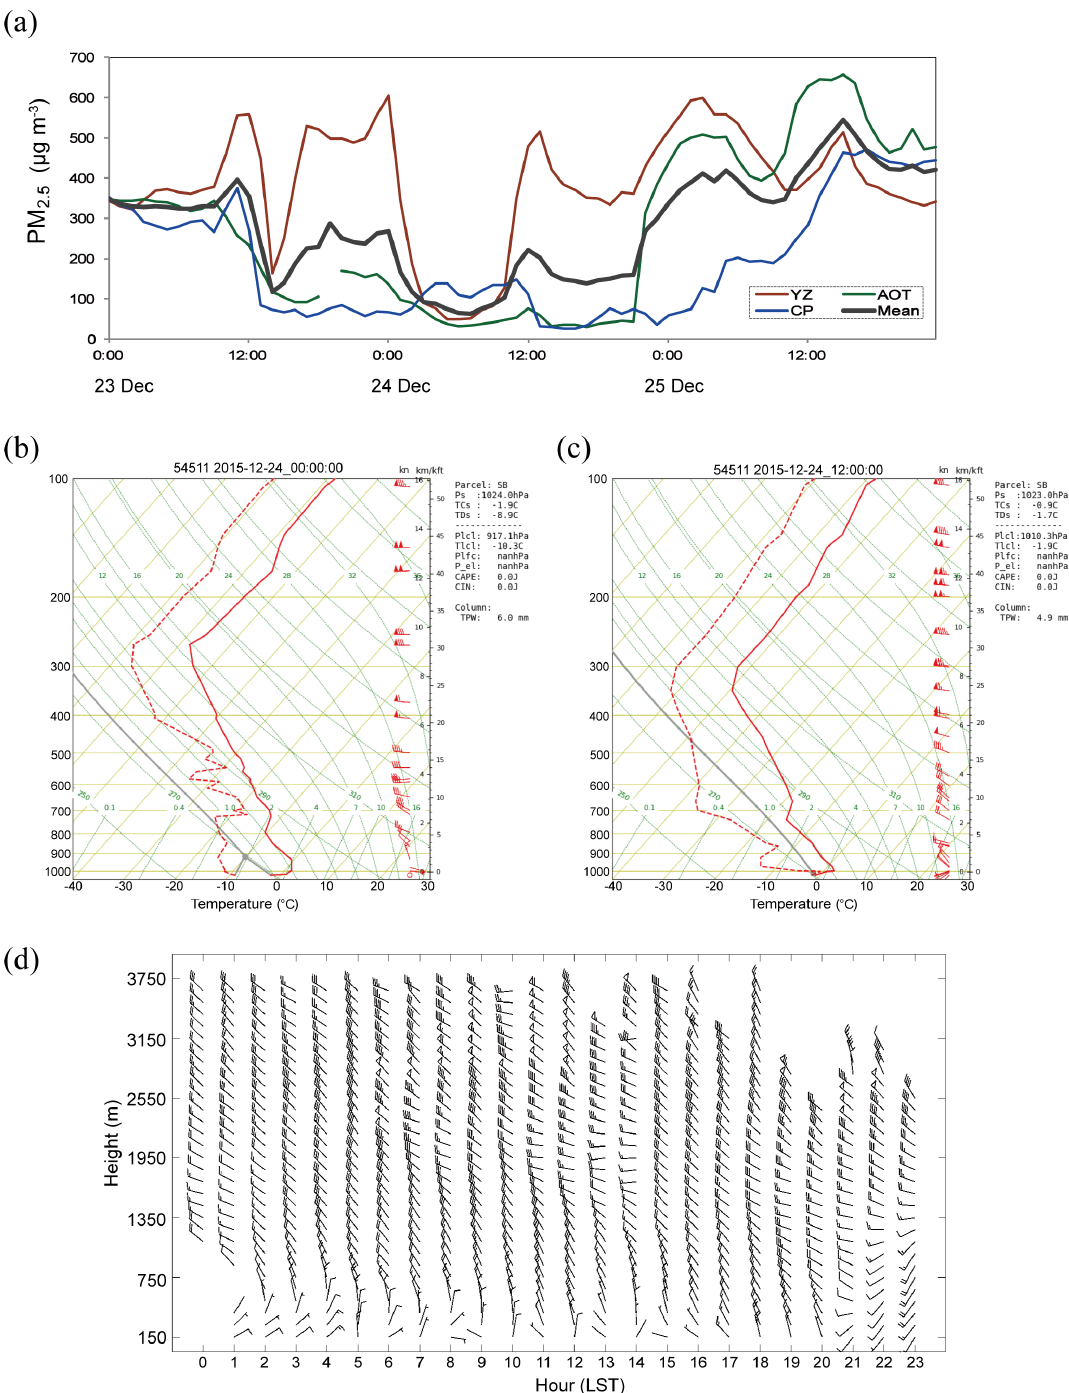
Figure 2. (a) Hourly-mean PM 2 . 5 concentration of CP, AOT, YZ and three-station mean in Beijing from 23 to 25 December. Temperature (solid), dew point (dashed) and wind vectors (in knots) from the radiosonde profiles at (b) 00:00UTC and (c) 12:00UTC at GXT. (d) Hourly wind-vector profiles from the wind profiler at HD on 24 December